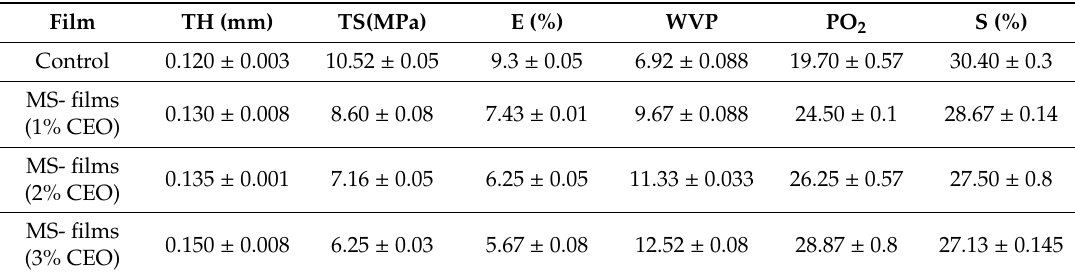
Table 2. Tensile strength (TS), thickness (TH), elongation at break (E), water vapor permeability (WVP), oxygen permeability coe ffi cient (PO 2 ), and the solubility (S) of millet starch films incorporated with di ff erent contents of